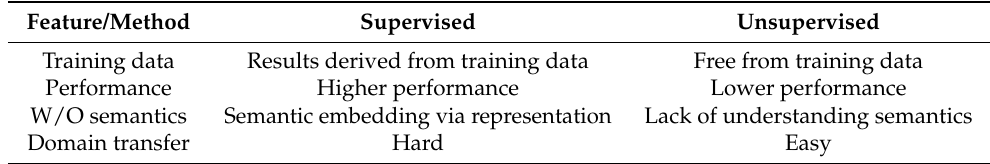
Table 1. Comparison of supervised and unsupervised similarity